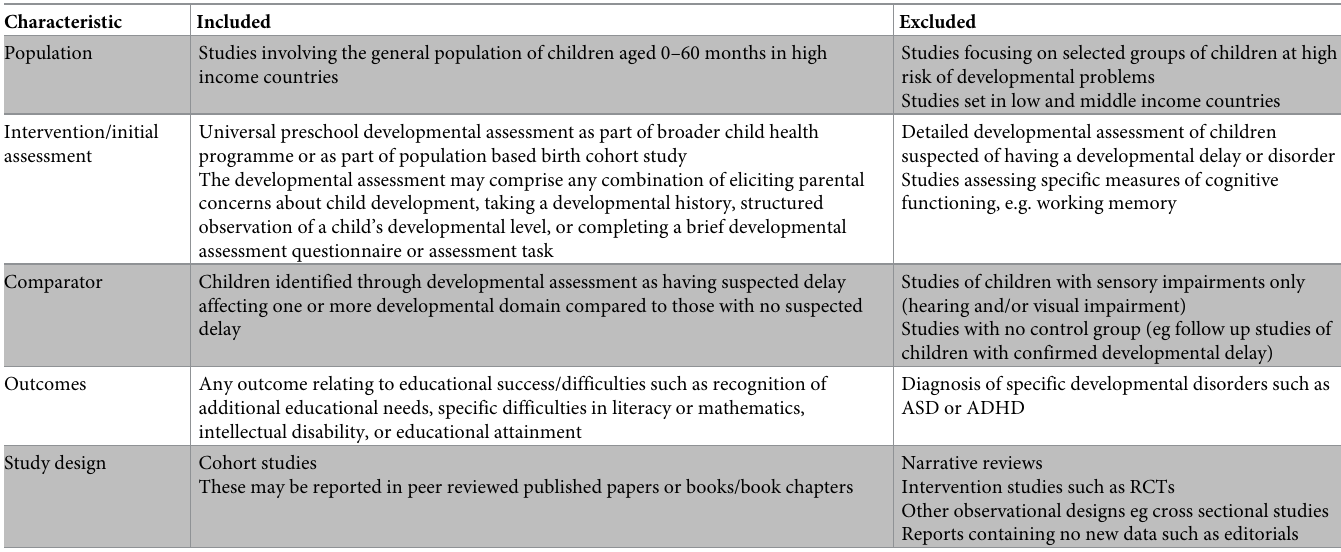
Table 1. Full inclusion and exclusion